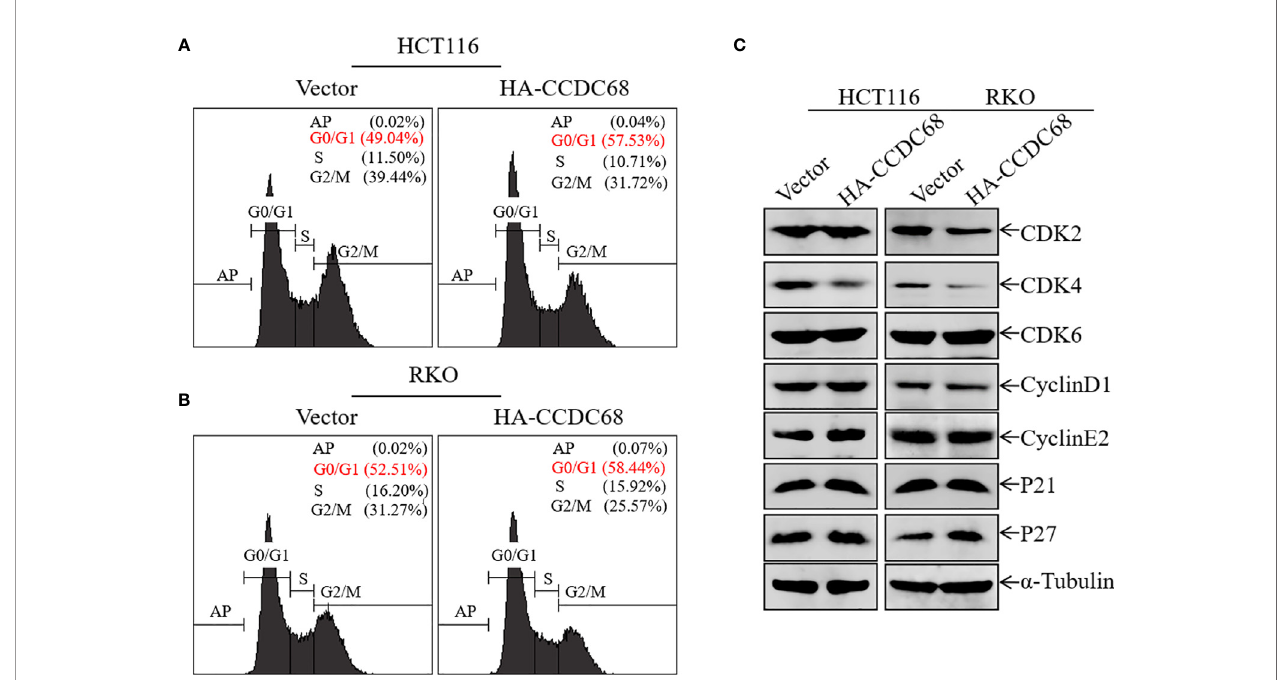
FIGURE 3 | Overexpression of CCDC68 induces G0/G1 phase arrest and downregulates CDK4 in CRC cells. (A, B) Cell cycle of HCT116 (Vector/HA-CCDC68) and RKO (Vector/HA-CCDC68) cells examined by fl ow cytometry. (C) Expression of positive cell cycle regulators in the G0/G1 phase of HCT116 (Vector/HA- CCDC68) and RKO (Vector/HA-CCDC68)